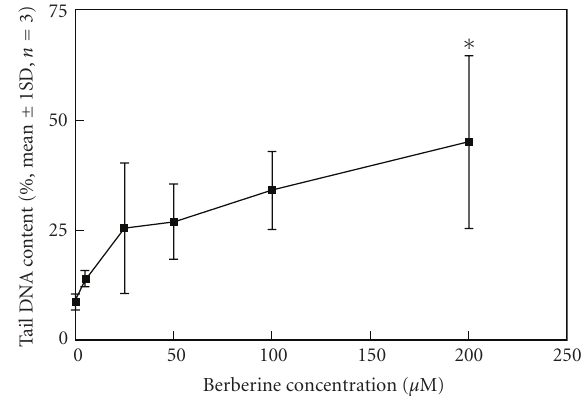
Figure 14: DNA damage of NCP/HK1 cells after 30 minutes. Treatment of berberine at di ff erent concentrations (5 to 200 μ M). DNA damage was expressed in percentage of DNA content in the Comet tails. The results are mean ± standard deviations of three individual experiments. Reprinted from Szeto et al. [115] with permission from the Turkish Journal Medical Science with permission from the